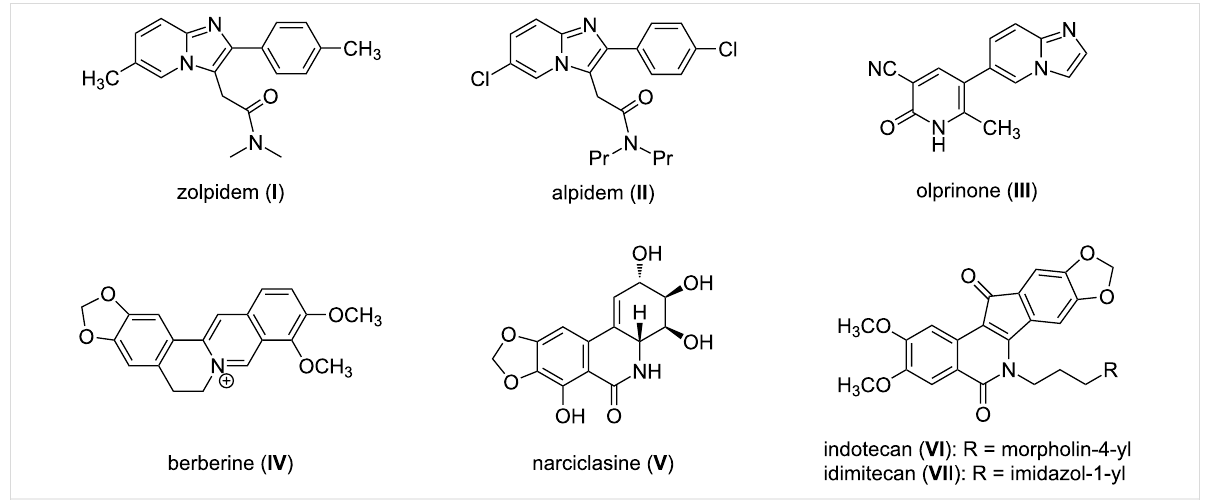
Figure 1: Representative bioactive imidazo[1,2- a ]pyridine and isoquinoline-containing